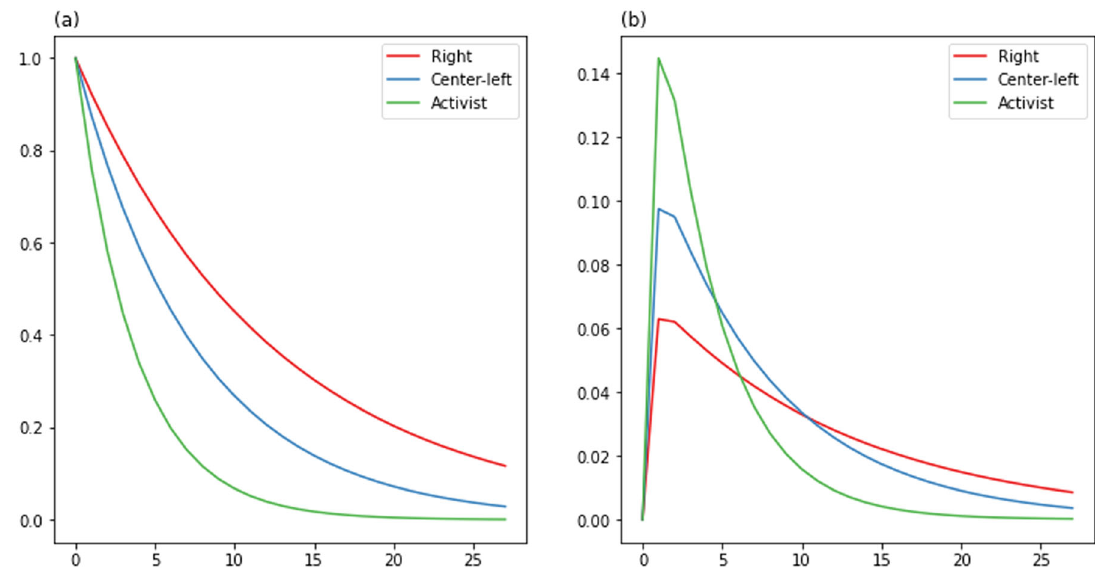
Fig. 3 Impulse response for naive autoregression. Projected impulse response over 28 days after a 1 SD shock to a within-group tweets and b protests. The x -axis shows day, y -axis predicted SD change in total tweets.